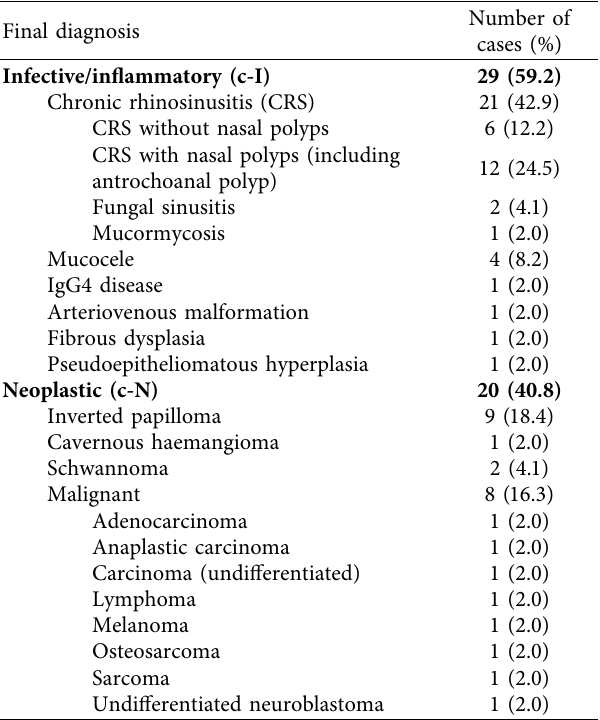
Table 2: Final clinical diagnoses.